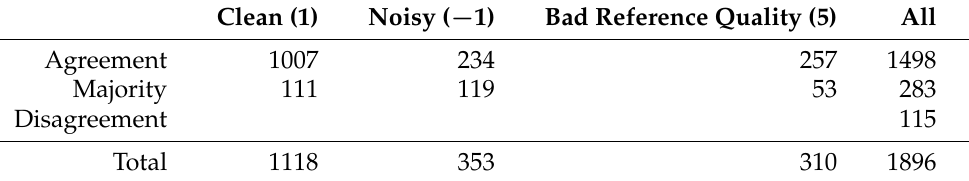
Table 4. Overview of the dataset. The rows represent the level of agreement. Agreement: all annotators agreed; Majority: three out of four annotators agreed; Disagreement: the annotators disagreed. The columns indicate the class to which the signals are assigned.